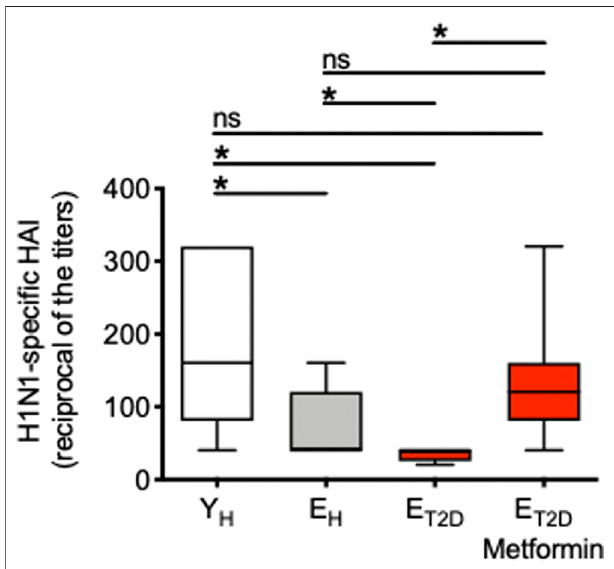
FIGURE 1 | Metformin signi fi cantly enhances the serum H1N1-speci fi c antibody response of E T2DM patients to the levels observed in E H and more importantlyinY H individuals.Serumsampleswerecollectedfromthe4groups of individuals and evaluated by H1N1-speci fi c HAI. Results show the reciprocal of the titers 4 weeks after vaccination. Mean comparisons between groups were performed by one-way ANOVA. * p < 0.05.